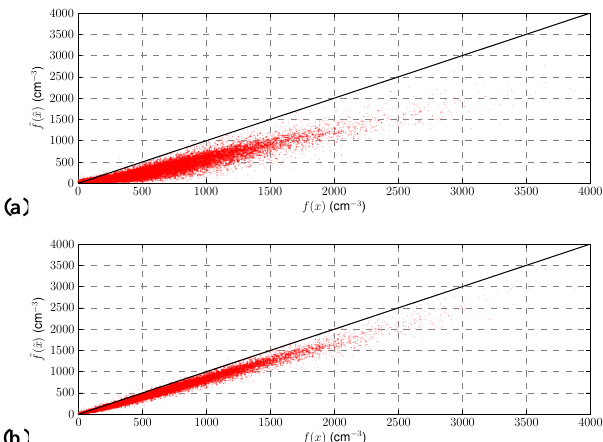
Fig. 5. Cloud droplet number concentrations (CDNC) computed with the approximate model ˜ f ( ˜ x ) as functions of CDNCs given by the accurate model f ( x ) . (a) Approximate parameterization with 4 size sections for the aerosol particle size distributions. (b) Approx- imate parameterization with 7 size sections for the aerosol particle size distributions. Black solid lines represent the identity lines.